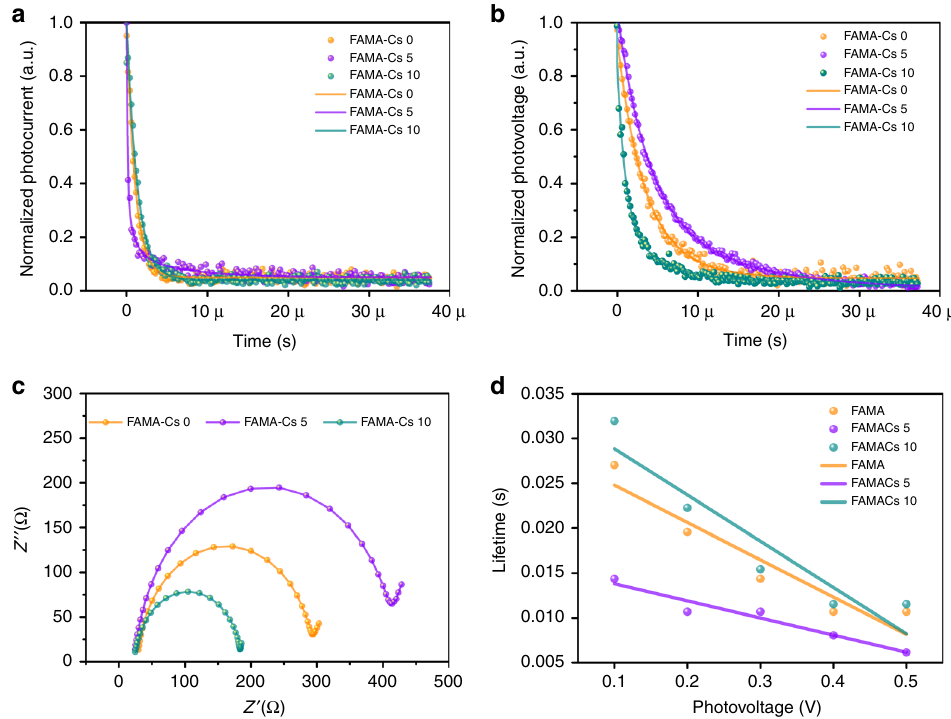
Fig. 6 Analysis of carrier dynamics. a TPC, b TPV, c EIS, and d IMPS analysis for FAMA perovskite samples with different cesium-doping concentration (volume ratio: 0, 5, and